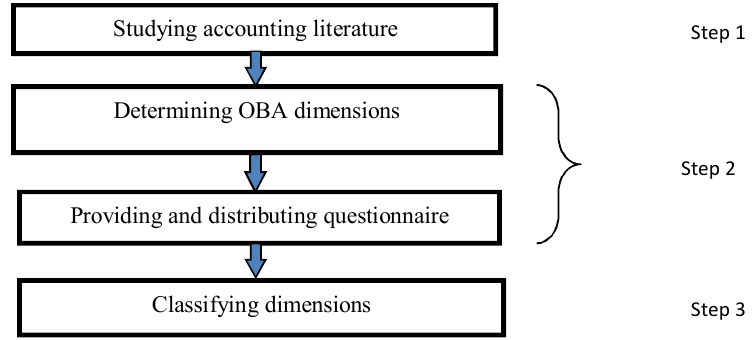
Fig. 2. Conduction process of the